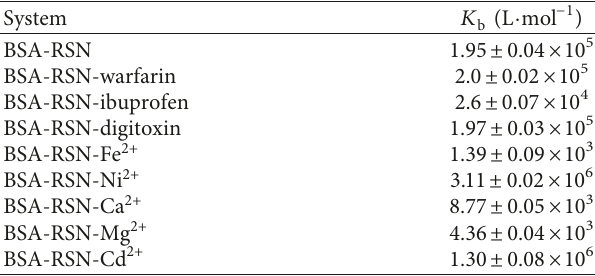
Figure 7: Plot of log [( F − F ) /F ] versus log [ Q ] for (a) site markers (digitoxin: A, warfarin: B, and ibuprofen: C) and (b) metal ions (Fe 2+ : A, 0 Ca 2+ : B, Mg 2+ : C, Ni 2+ : D, and Cd 2+ : E) at 297 K and pH 7.40. Table 3: The binding constant of the BSA-RSN system in the presence of site markers and metal ions at 297K (pH